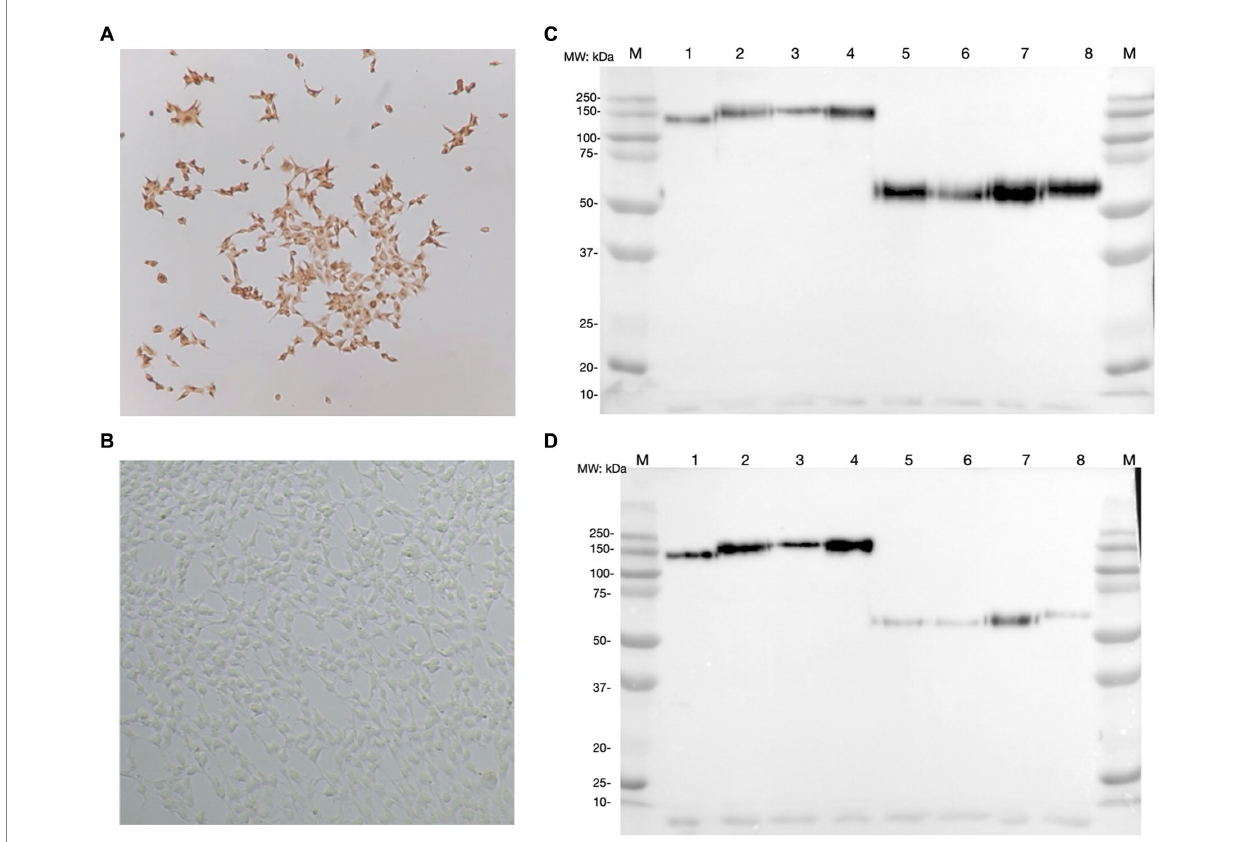
FIGURE 2 Detection of classical swine fever virus (CSFV) E2 expression by immunocytochemistry staining (ICC) and western blot (WB). (A) The result of ICC in detecting the expression of CSFV E2 glycoprotein using anti-V5 antibody. (B) The ICC result of mock transfected HEK 293 cells (C) Western blot result of different CSFV genotypes of E2 glycoproteins detected by anti-V5 antibody. (D) Western blot result of different CSFV genotypes of E2 glycoproteins detected by WH303 antibody. The ICC were performed 7 days after the transfection in HEK 293 cells fixed with 80% acetone for the immunostaining. Proteins after purification with HisPurTM cobalt resin and separated by SDS-PAGE in both naïve and reduced gels were analyzed by WB detected with anti-V5 or anti-WH303 antibodies. The positions of markers are as indicated. 1, CSFV G 1.1 E2 naïve form; 2, CSFV G 2.1a E2 naïve form; 3, CSFV G 2.1d E2 naïve form; 4, CSFV G 3.4 E2 naïve form; 5, CSFV G 1.1 E2 reduced form; 6, CSFV G 2.1a E2 reduced form; 7, CSFV G 2.1d E2 reduced form; 8, CSFV G 3.4 E2 reduced form; M,